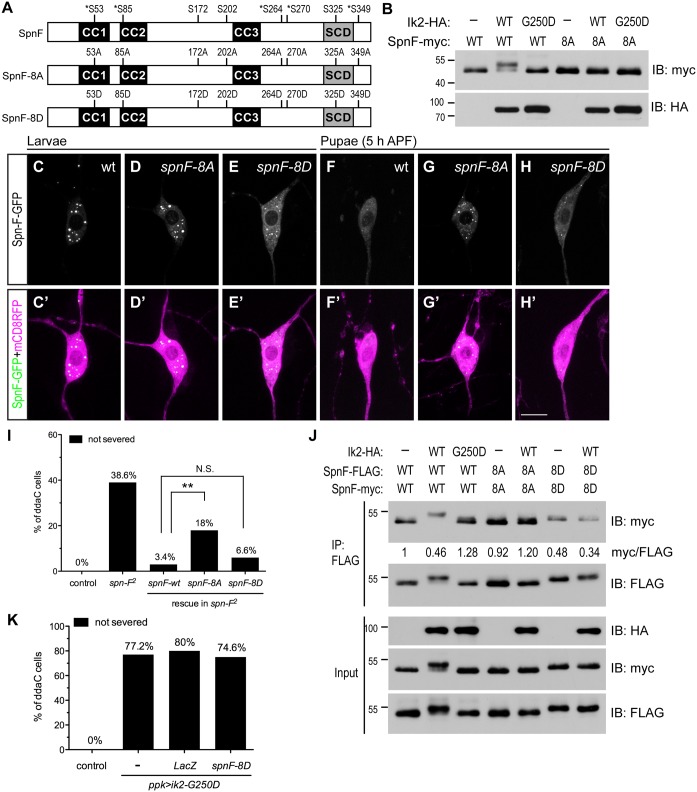
The phosphorylation of Spn-F by Ik2 kinase is required for Spn-F distribution and dendrite pruning.(A) Schematic shows the amino-acid residues of Spn-F protein phosphorylated by Ik2 kinase as identified by mass spectrometry. Five serine residues phosphorylated by Ik2 specifically are indicated by asterisks, and three serine residues with increased phosphorylation level in S2 cells with Ik2 overexpression are shown. These eight serine residues of Spn-F were mutated to alanines to generate phospho-resistant SpnF-8A mutant, or to aspartic acids to make phospho-mimetic SpnF-8D mutant. (B) Wild-type Spn-F or SpnF-8A was expressed in S2 cells alone, or together with wild-type Ik2 or kinase-dead Ik2-G250D mutant, and lysates were used for immunoblot analyses. (C'-H') The C4da neurons labeled by ppk-GAL4 and UAS-mCD8RFP are shown. In ddaC neurons of wild-type larvae, SpnF-GFP (C), SpnF-8A-GFP (D) and SpnF-8D-GFP (E) showed punctate pattern. At 5 h APF, both SpnF-GFP (F) and SpnF-8D-GFP (H) puncta were dispersed, whereas SpnF-8A-GFP (G) remained as puncta. (I) Quantitative analysis of dendrite pruning phenotypes in ddaC cells at 16 h APF. SpnF-8D, not SpnF-8A, rescued pruning defects in ddaC neurons of spn-F
2 mutants. The percentage of ddaC neurons shows dendrite pruning defects among the total number of neurons examined. For wild-type control, n = 50; for spn-F
2 mutants, n = 70; for spn-F
2 mutants rescued with wild-type spn-F, n = 88; for spn-F
2 mutants rescued with spnF-8A, n = 100; for spn-F
2 mutants rescued with spnF-8D, n = 106. N.S., not significant. **, p = 0.0019. Statistical analysis was performed with Fisher’s exact test. (J) Co-IP experiments with lysates from S2 cells cotransfected with wild-type spn-F, spnF-8A or spnF-8D alone, and together with wild-type ik2 or mutant ik2-G250D show that phosphorylation of Spn-F by Ik2 kinase decreases the self-association of Spn-F proteins. The myc/FLAG ratio (by ImageJ) indicates the relative amounts of Spn-F-myc protein associated with Spn-F-FLAG protein in co-IP experiments with anti-FLAG antibody. (K) Quantitative analysis of dendrite pruning phenotypes in ddaC cells at 16 h APF. The percentage of ddaC neurons shows dendrite pruning defects among the total number of neurons examined. For wild-type control, n = 100; for ppk>Ik2-G250D mutants, n = 92; for ppk>Ik2-G250D, LacZ mutants, n = 50; for ppk>Ik2-G250D mutants rescued with spnF-8D, n = 122.Scale bar, 10 μm.